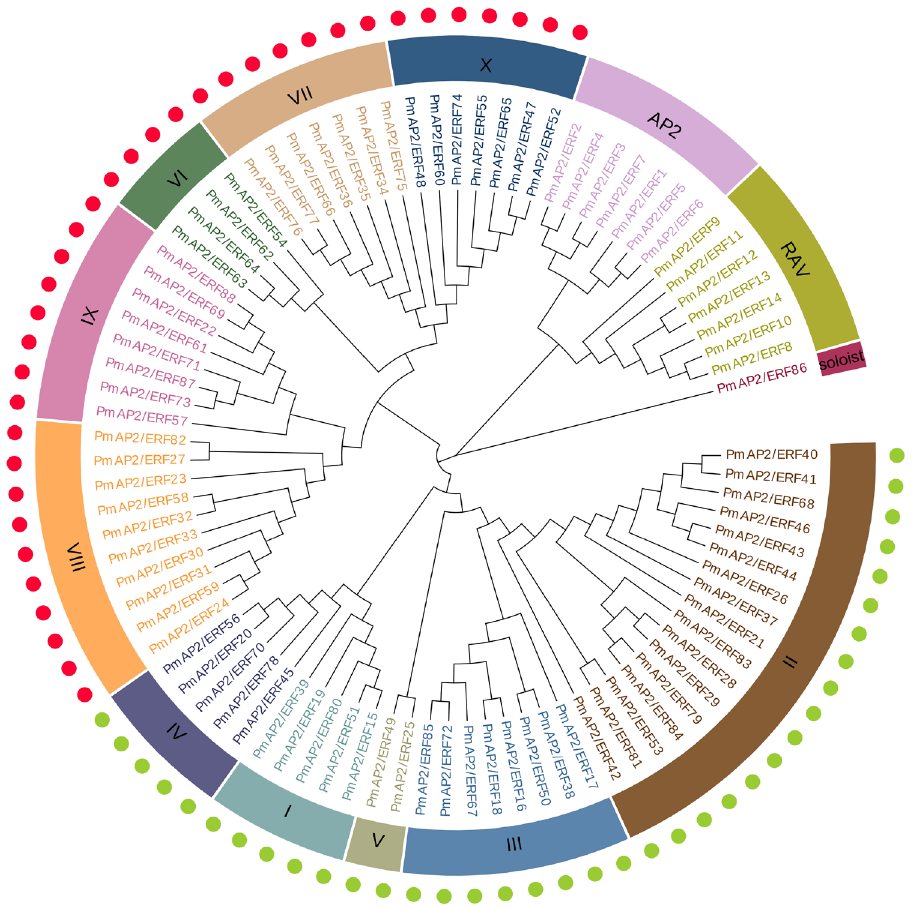
Figure 1. Phylogenetic grouping of AP2/ERF superfamily members in P. massoniana . AP2 family, RAV family and ten clades (I-X) of ERF family were shown in a different coloured circle strip. DREB and ERF subfamilies were shown using green and red dots respectively. phylogenetic tree was constructed using MEGA X with ML